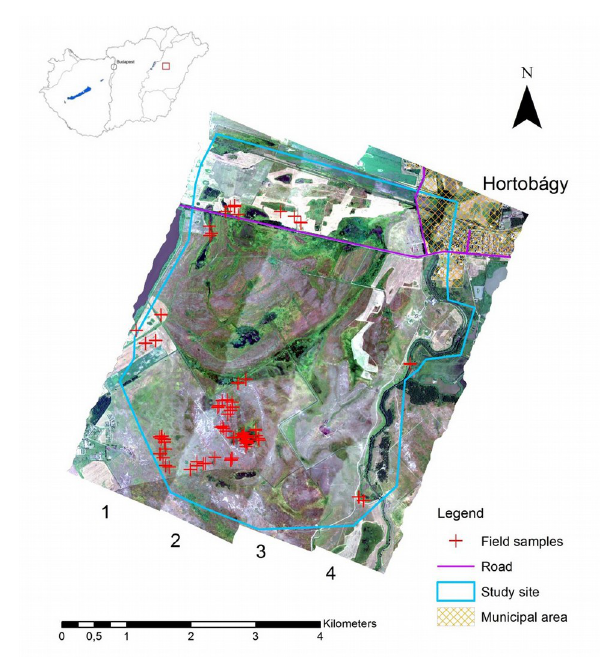
Figure 1. Overview map of the study site. We indicated the positions of field measurement plots in the RGB mosaic of the hyperspectral image with red cross marks